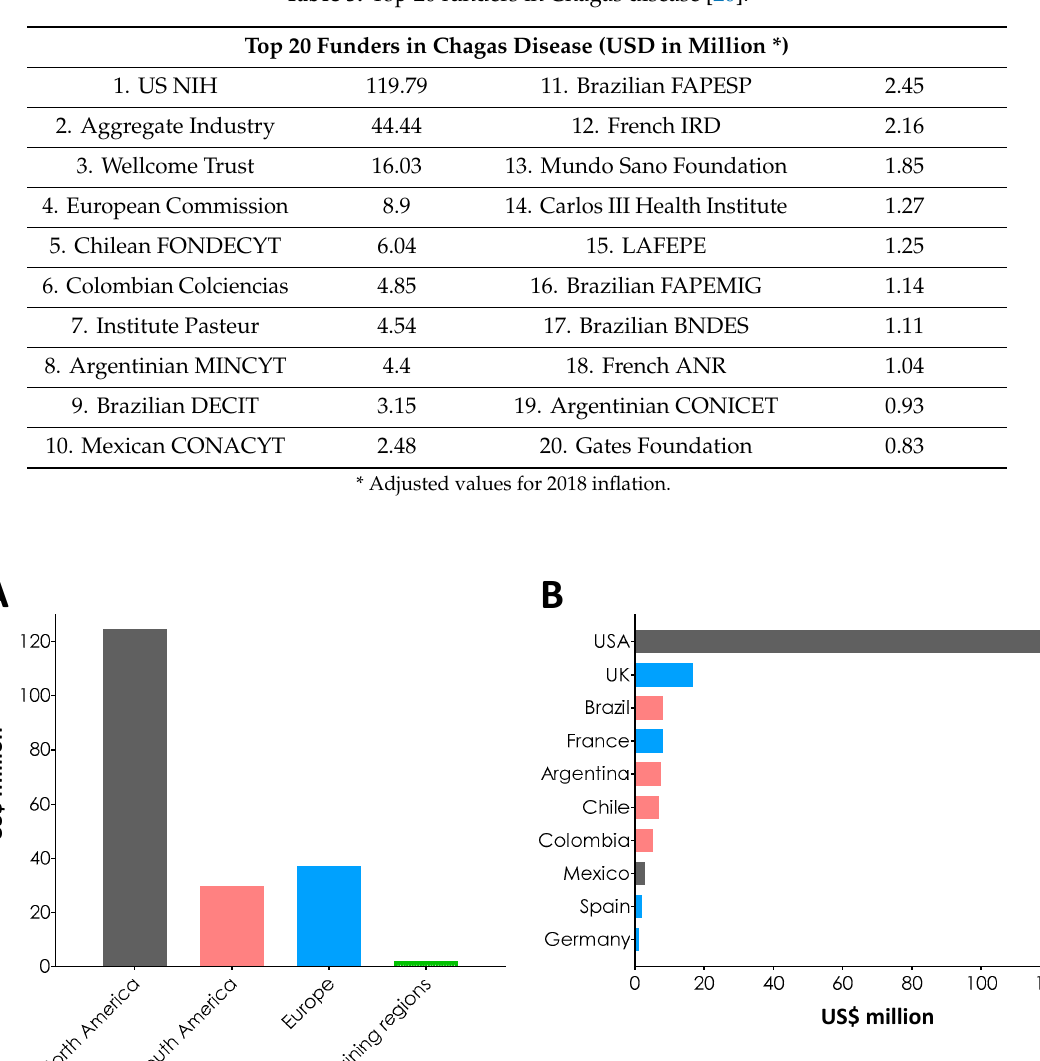
Table 3. Top 20 funders in Chagas disease [20].